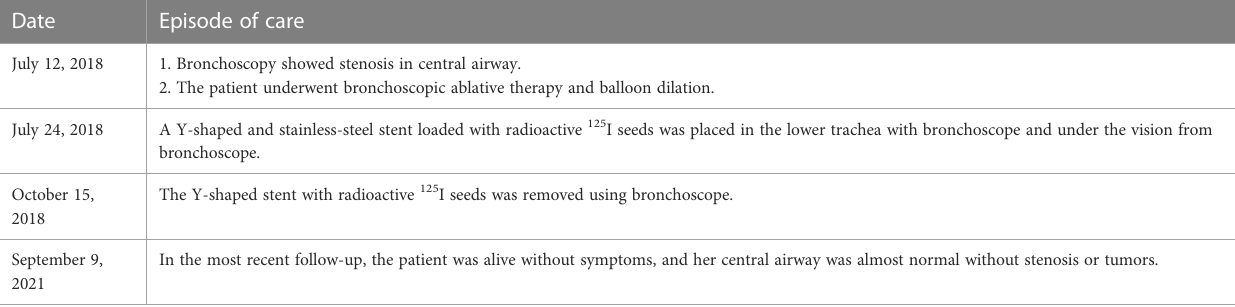
TABLE 1 The timeline with the episode of